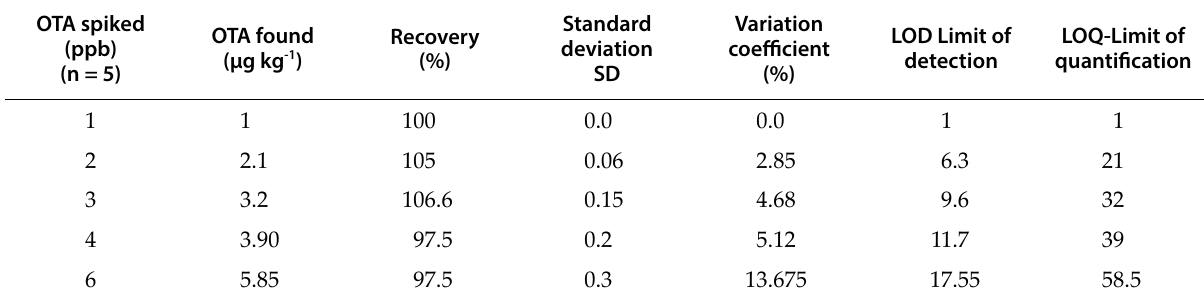
Table 1. Validation of the method was performed with spiked CRM. OTA spiked